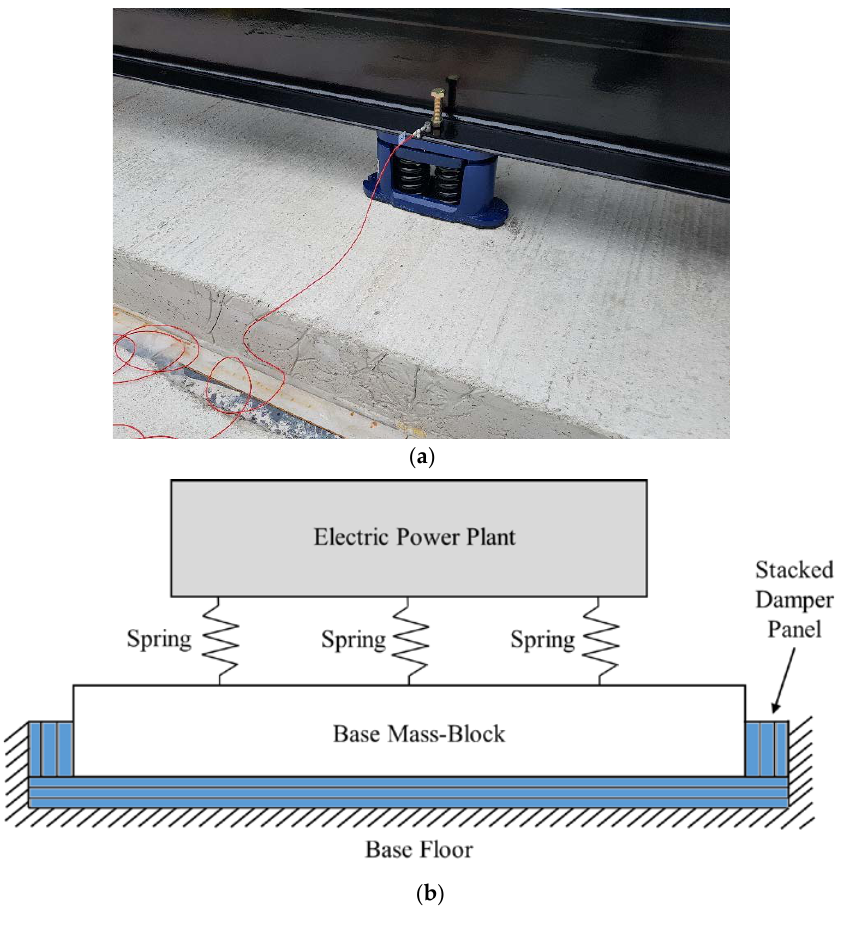
Figure 2. Passive-type current mount module for electric power plant. ( a ) Side view; ( b ) Mount diagram. Table 1. Specification of electric power plant.